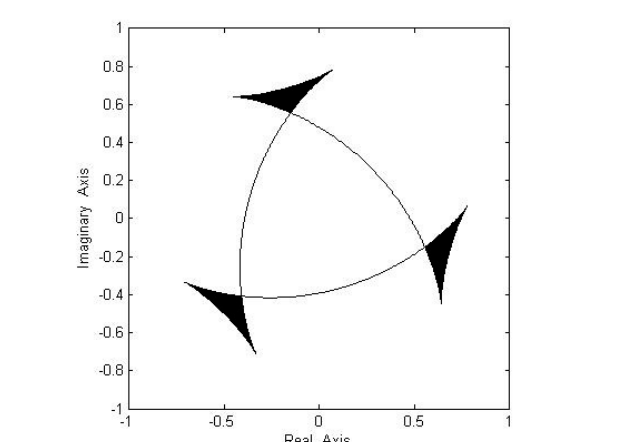
Figure 2. The boundary of